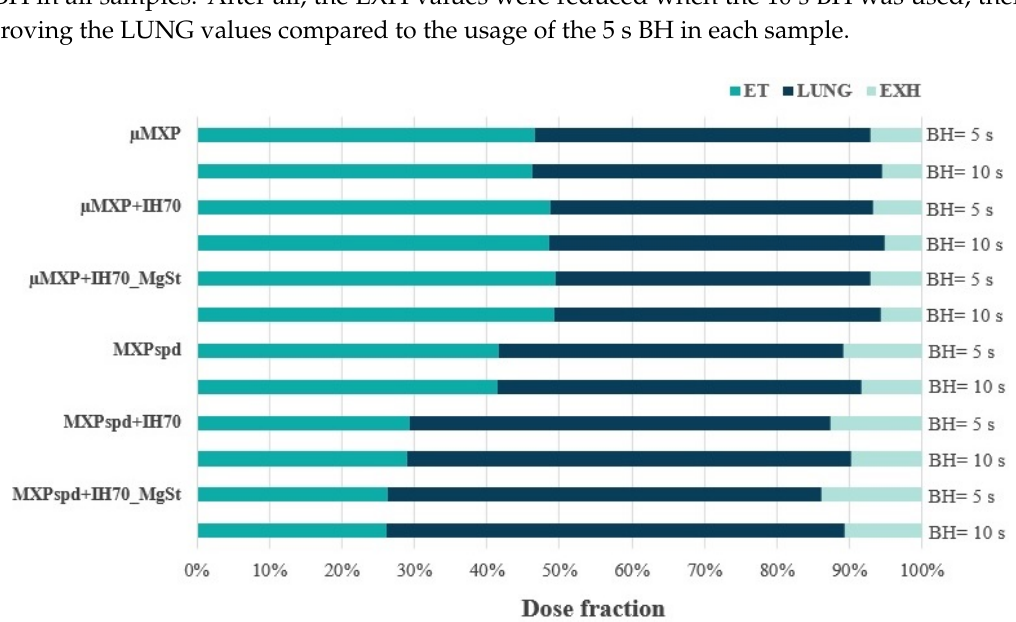
Figure 5. Dissolution test results of the raw MXP, µMXP, and MXPspd.